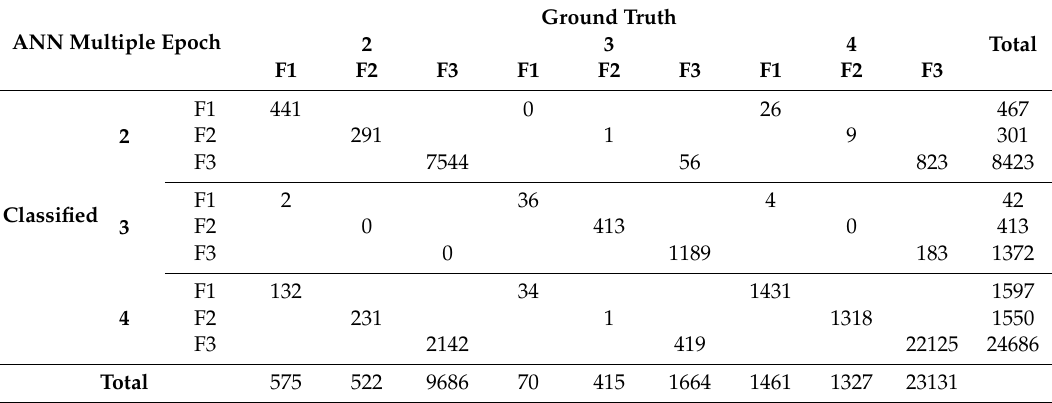
Table A7. Confusion matrix of multitemporal classification performed with the Artificial Neural Networks (ANN) classifier, F1 - farm 1, F2 - farm 2 and F3 - farm 3.